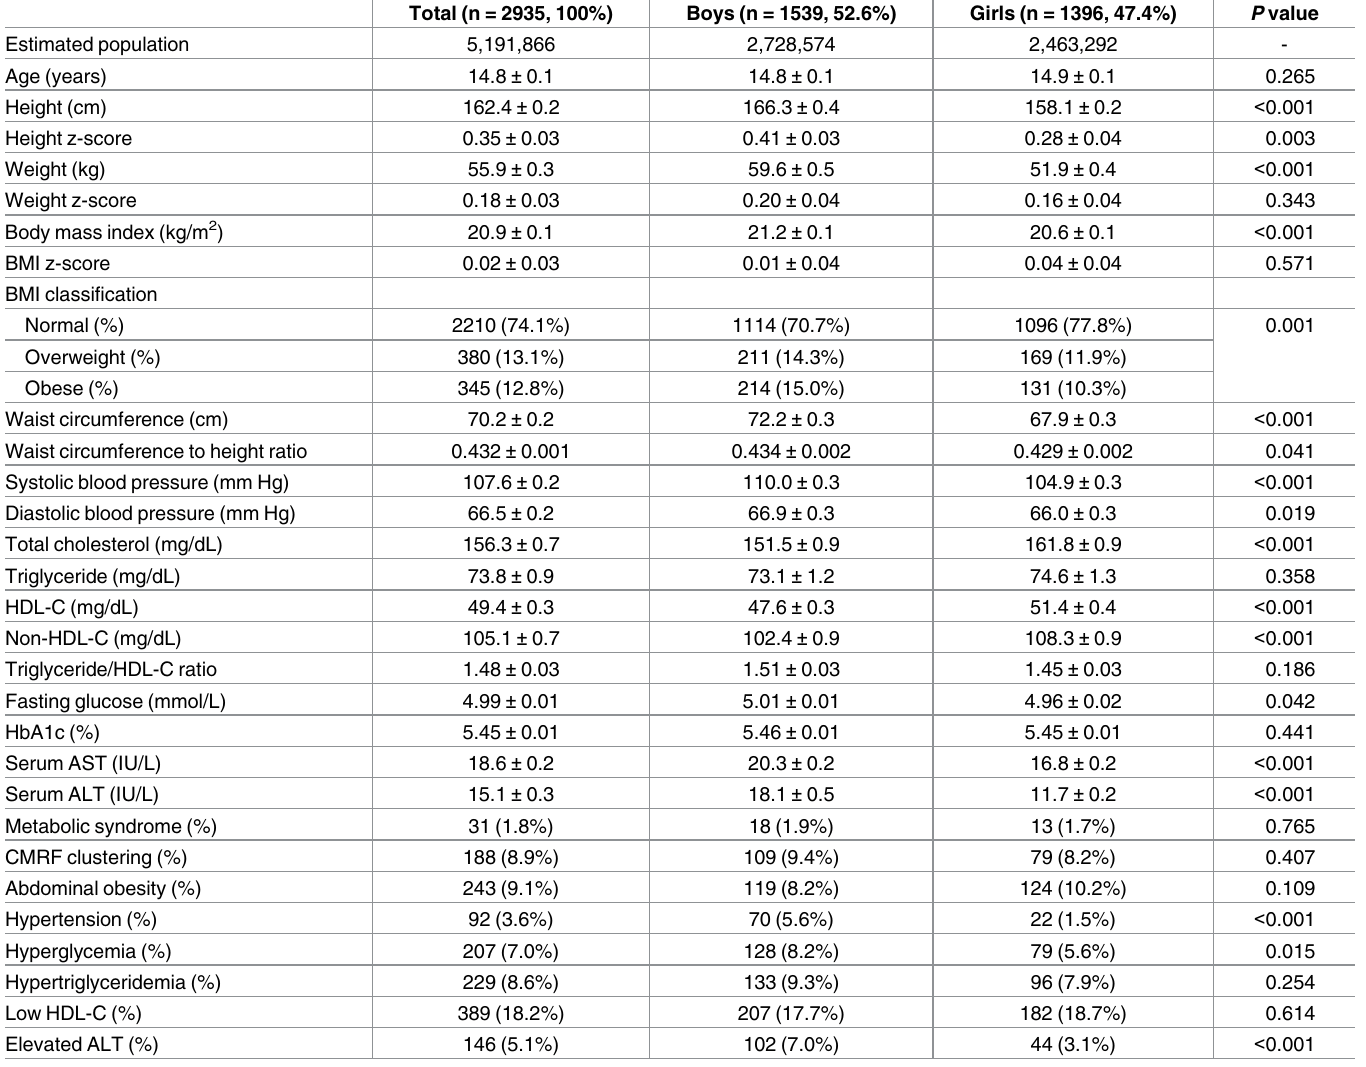
Table 1. Anthropometric, clinical, and biochemical characteristics in study